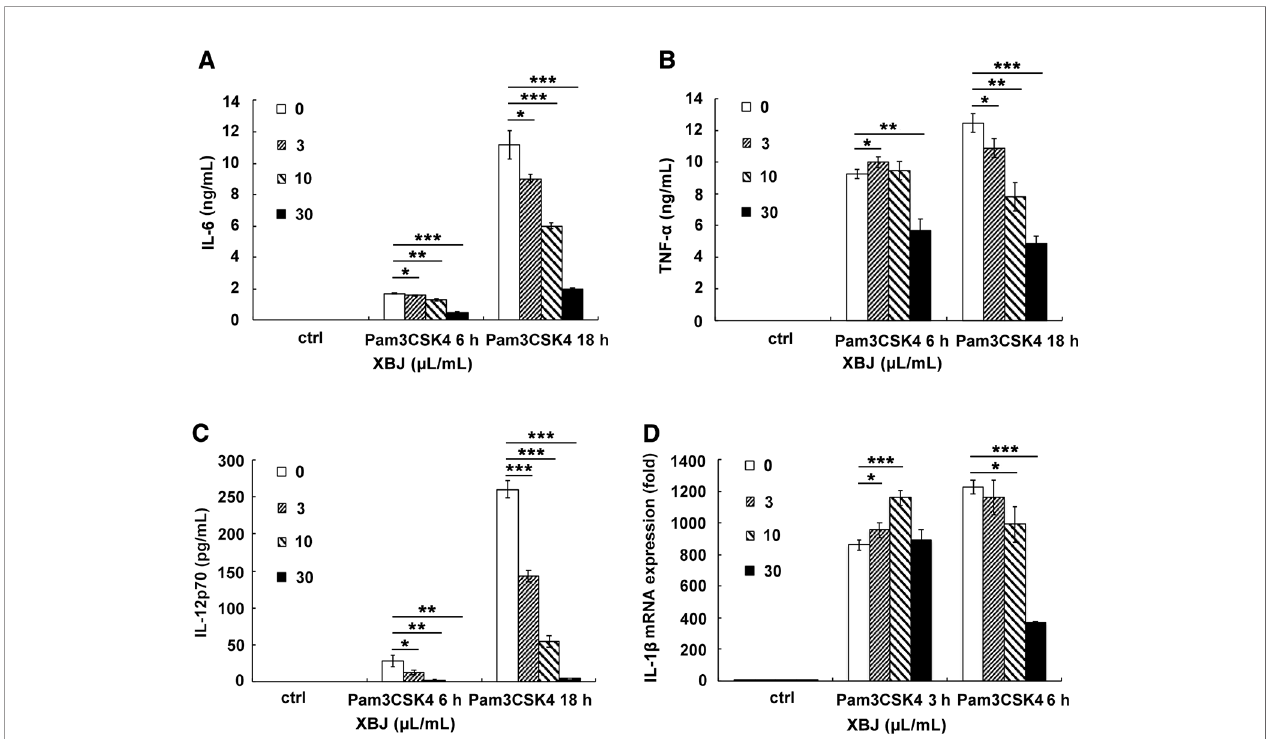
FIGURE 7 | XBJ decreased the production of Pam3CSK4-induced IL-6, TNF- a , IL-1 b , and IL-12 in mouse primary macrophages. Mouse primary peritoneal macrophages were seeded at 3.5 × 10 5 cells/well in 24-well plates and cultured overnight. Cell were treated with a range of concentration of XBJ with or without Pam3CSK4 (100 ng/ml) for 3, 6, or 18 hours. The concentrations of IL-6 (A) , TNF- a (B) , and IL-12p70 (C) in the cell culture supernatant were detected by ELISA. And the expression of IL-1 b (D) mRNA was examined by qRT-PCR. Data were shown as mean ± SD (n=3). * , ** , ***Signi fi cantly different at p < 0.05, p < 0.01, and p < 0.001,